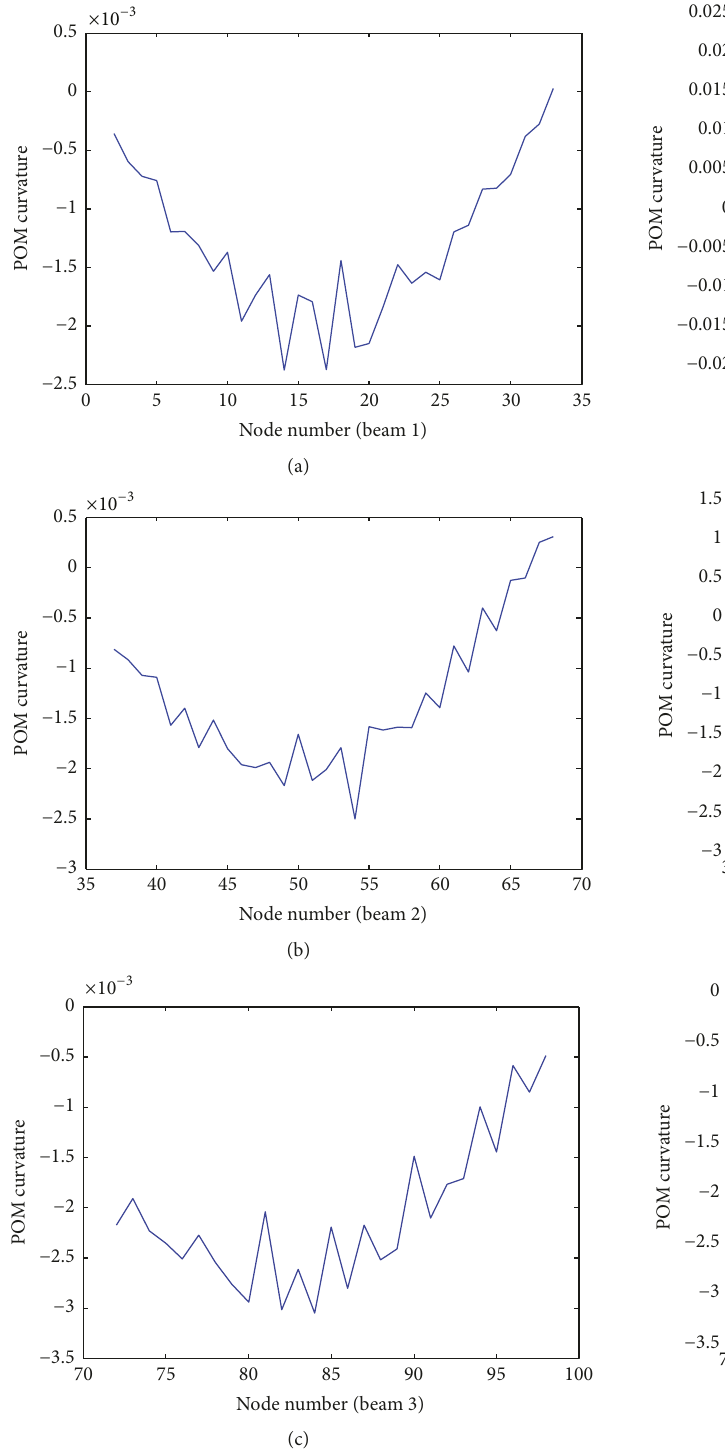
Figure 8: POM curvature curves using FRFs in the region (C) containing 1% external noise: (a) beam 1, (b) beam 2, and (c) beam